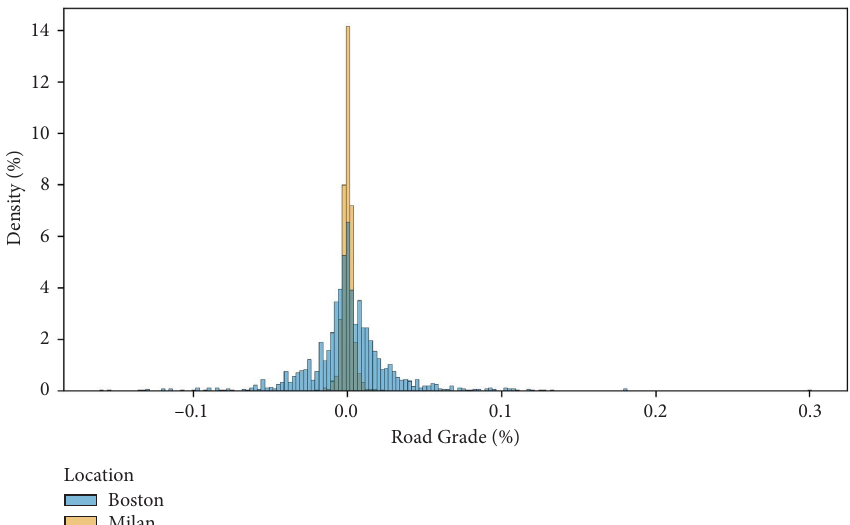
Figure 7: Road grade distribution for bus routes of MBTA (Boston) and AMAT (Milan).